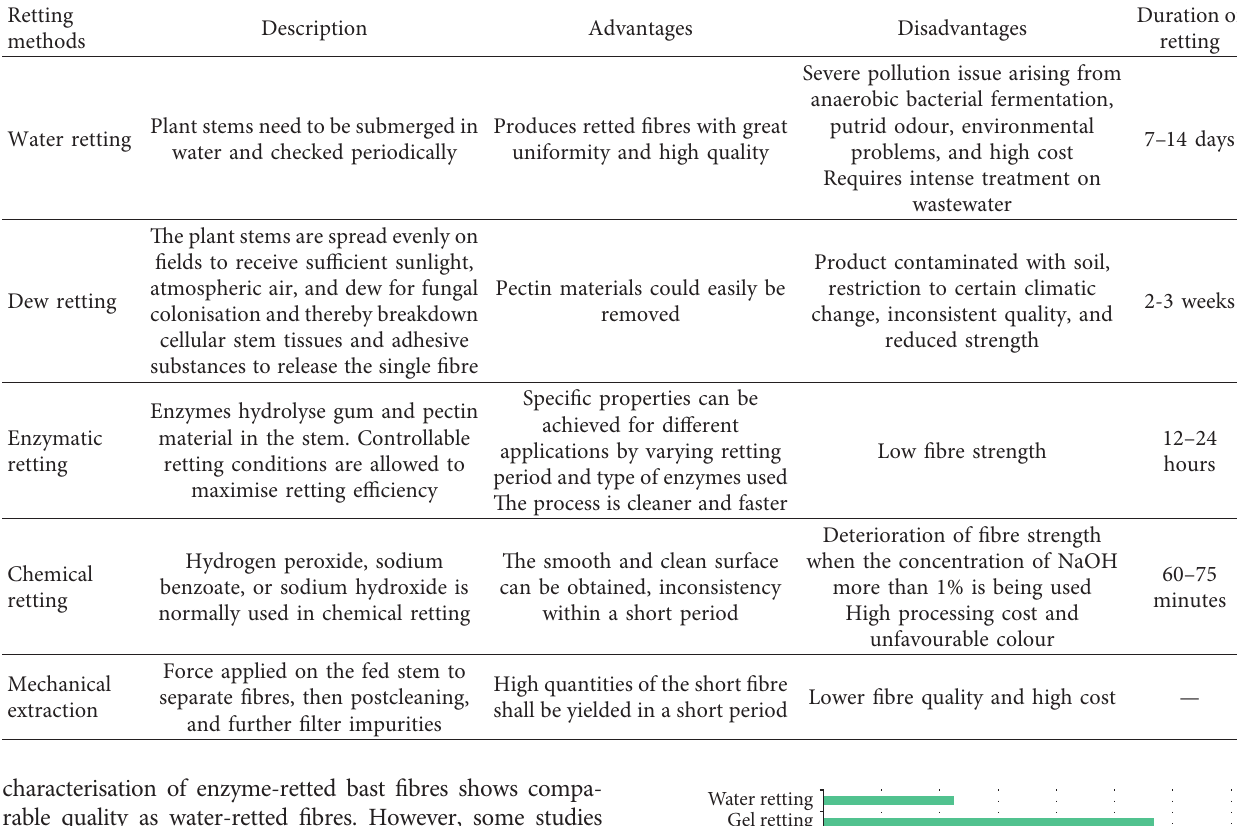
Table 2: The comparison between bast fibre retting and extraction process [24].